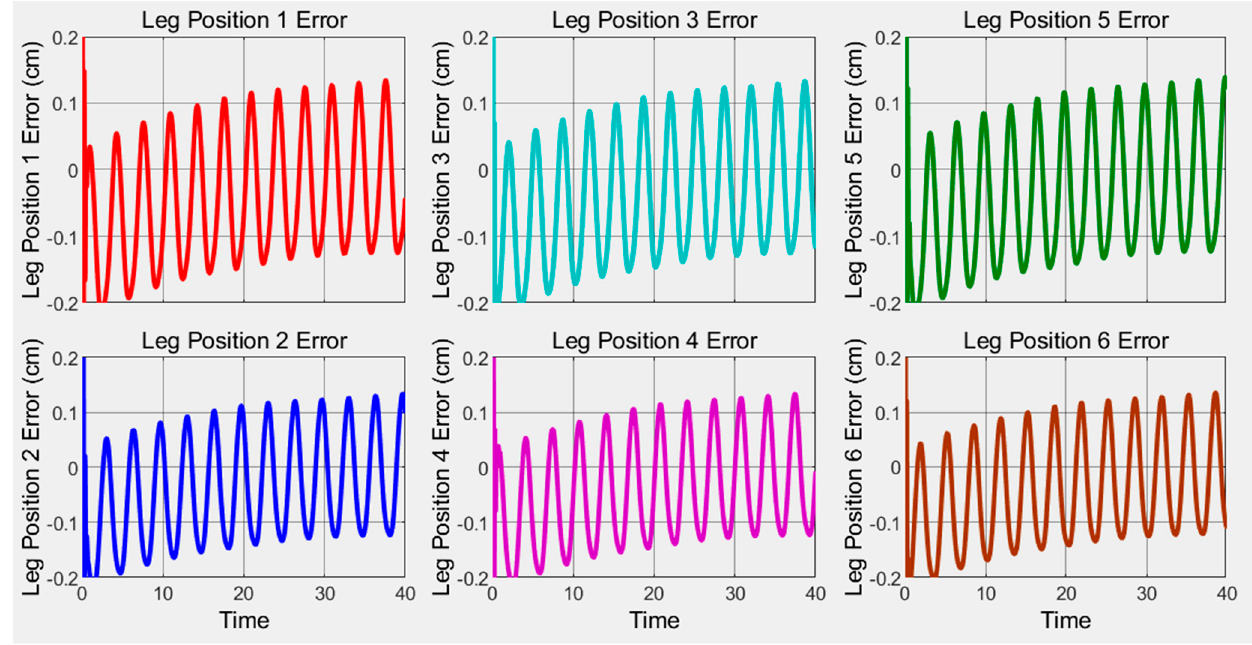
Figure 17. Leg position error simulation results for reference trajectory.